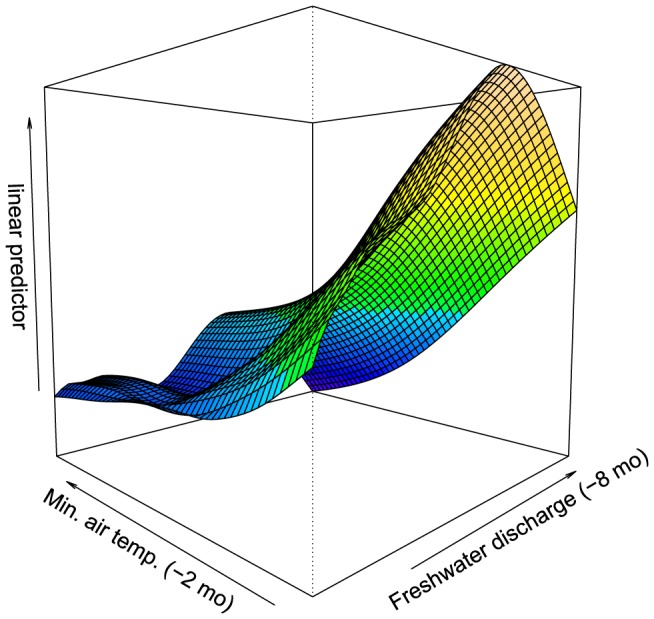
Final model of dugong natural mortality (linear predictor, loge x + 1) in response to mean minimum air temperature (°C, lagged by 2 months) and freshwater discharge (m3s−1, lagged by 8 months and square-root transformed).